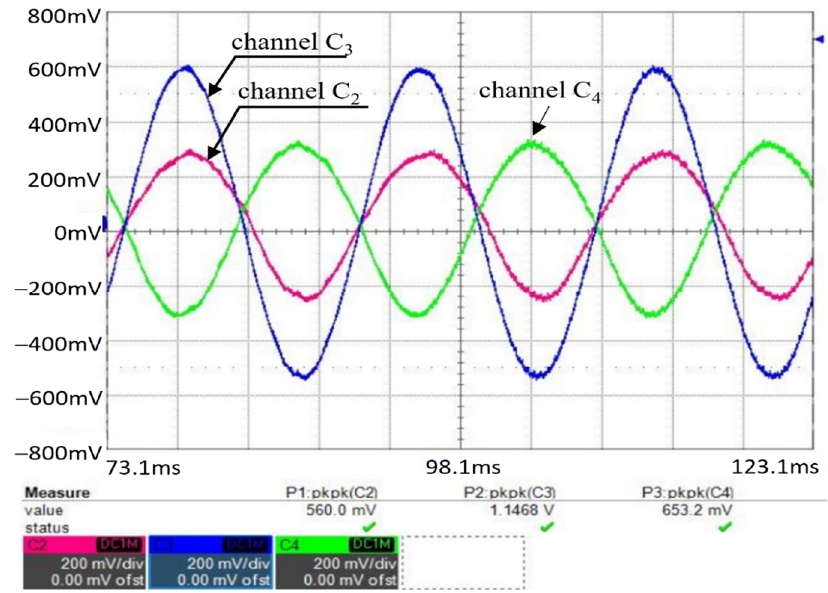
Figure 17. PQ control experiment: Phase output current waveform of the micro inverter (channel C4) and that flowing from the micro ST (channel C2). Phase load current waveform (channel C3).